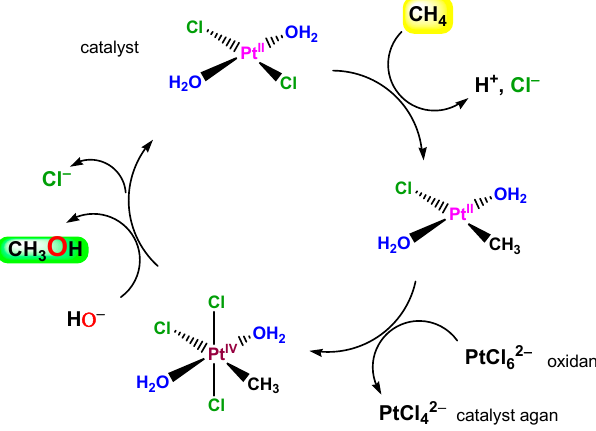
Figure 20. A schematically depicted catalytic cycle proposed for Shilov chemistry (the methane oxidation to methanol by Pt IV Cl 62 − catalyzed by Pt II Cl 42 − ). The initial step of the reaction between alkane and ion Pt II Cl 42 − is the formation of a σ‐ alkyl platinum(II) derivative, which in the second step is oxidized by platinum(IV) present in the solution to give alkanol (and also alkyl chloride):